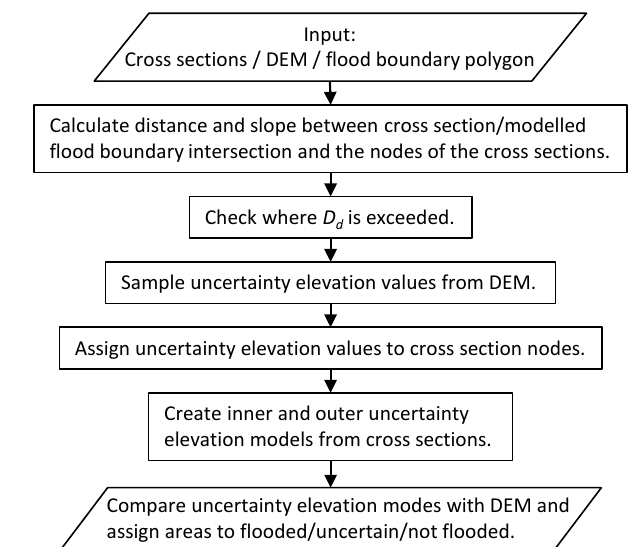
Figure 2. Simplified flowchart of work steps.